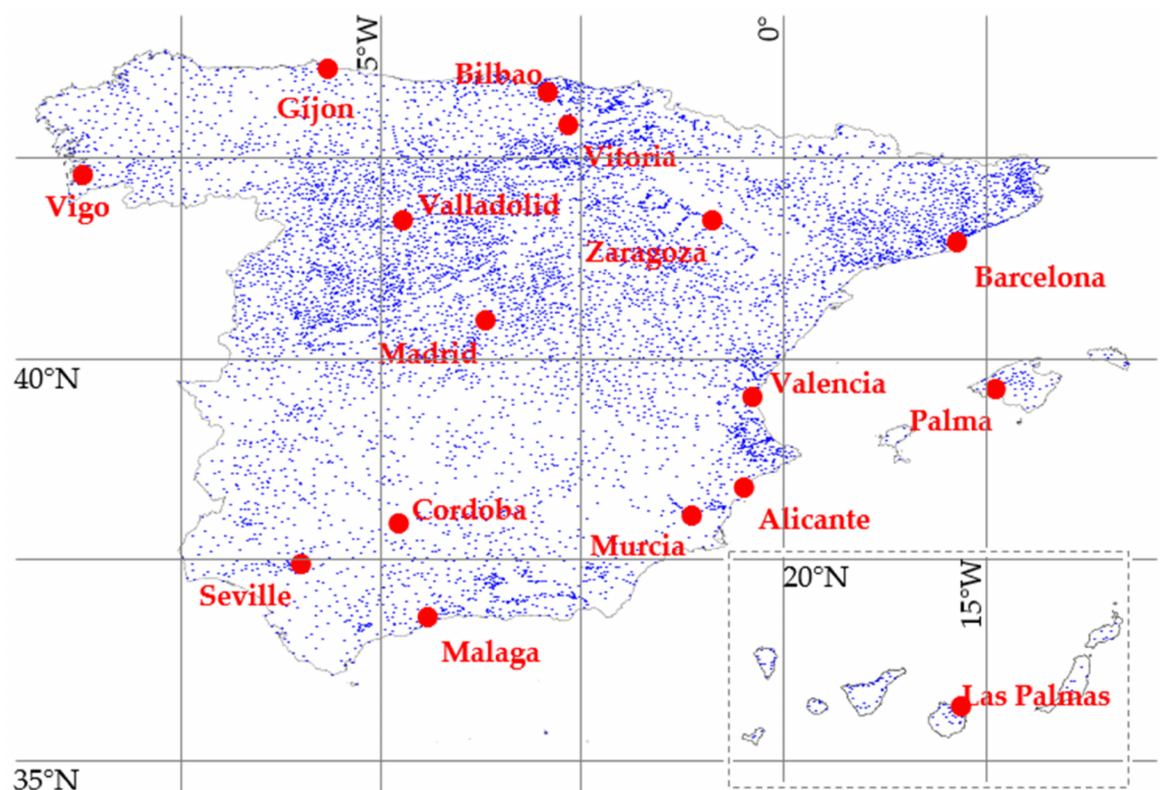
Figure 2. Location of 8131 municipalities of Spain (highlighting cities > 250 k